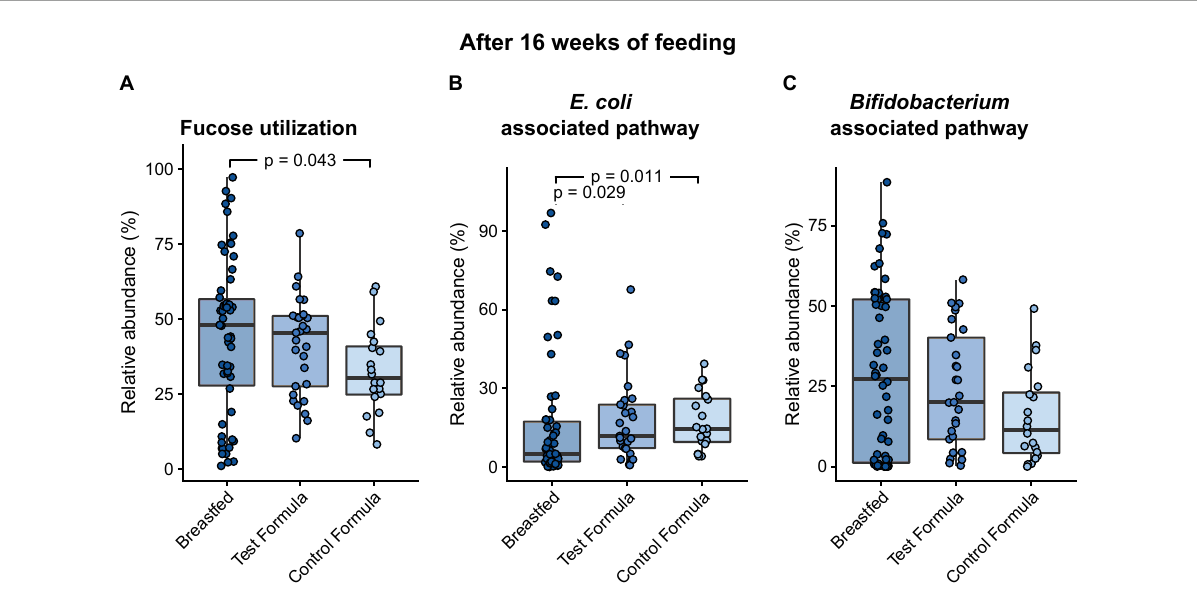
FIGURE5 Box plots of the relative abundance of MGS that carry the functional potential to grow on fucose after 16 weeks of feeding in infants in the three feeding groups: Breastfed, test formula, and control formula. Comparisons between feeding groups were carried out for the total abundance of MGS with the functional potential to grow on fucose (A) , MGS carrying the pathway annotated in E. coli (B) , and MGS carrying the pathway annotated in B. breve (C) . Horizontal lines indicate the median; box boundaries indicate the interquartile range; whiskers represent values within 1.5 × the interquartile range of the first and third quartiles. Statistics: Mann–Whitney U -test. P -values < 0.05 are